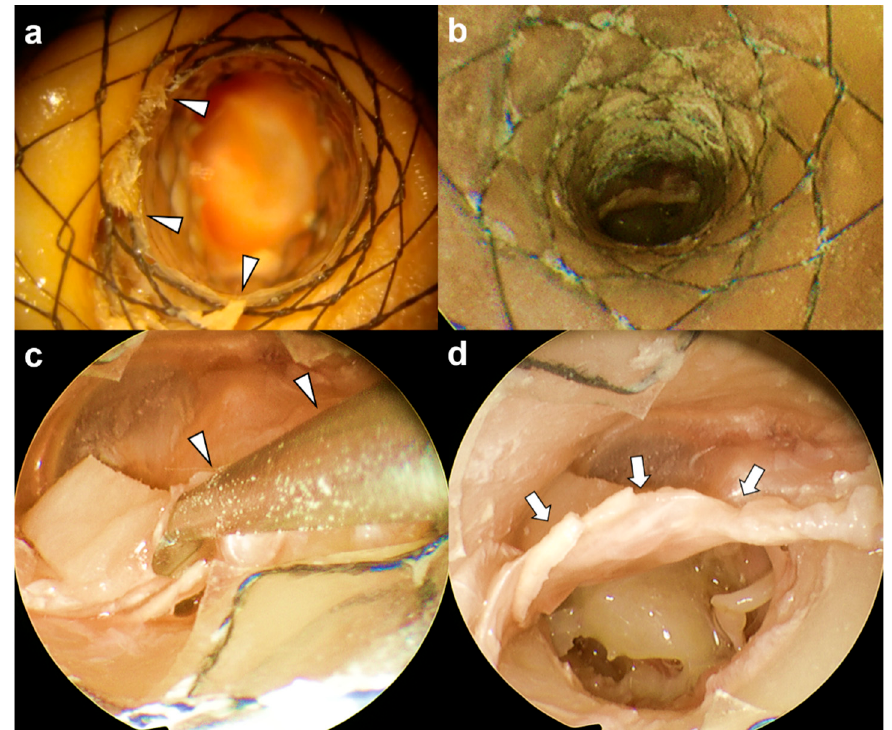
Figure 4. Endoscopic images obtained immediately after tympanomeatal flap (TMF) elevation in the self-expandable retainer (SER) group. ( a ) Endoscopic image showing the bare type of SER and hairs and earwax (arrowheads) in the external auditory canal visible through the wire mesh of the SER. ( b ) Endoscopic image showing the fully covered SER. ( c ) TMF elevation was performed using a canal knife (arrowheads). ( d ) A successfully elevated tympanic membrane (arrows).